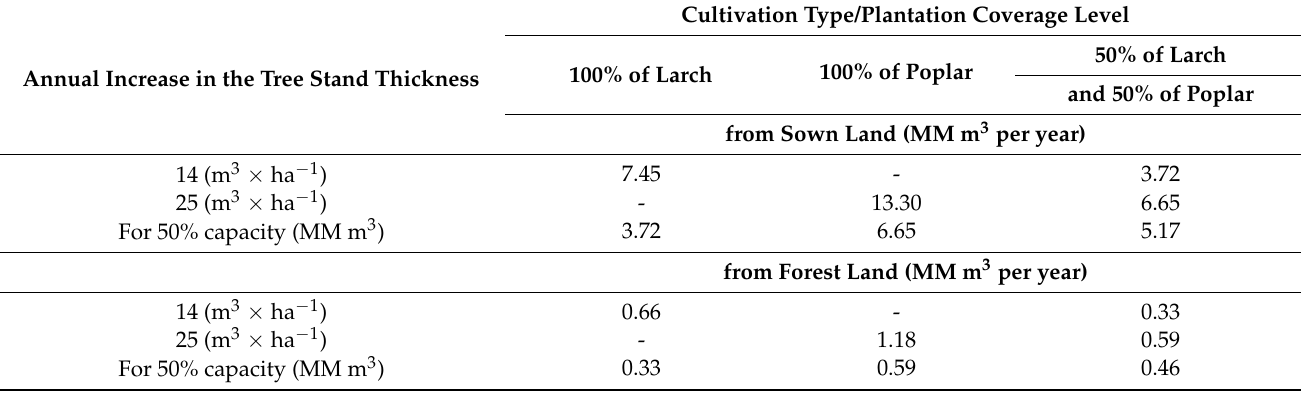
Table 3. Data on the potential wood base from sown land and forest